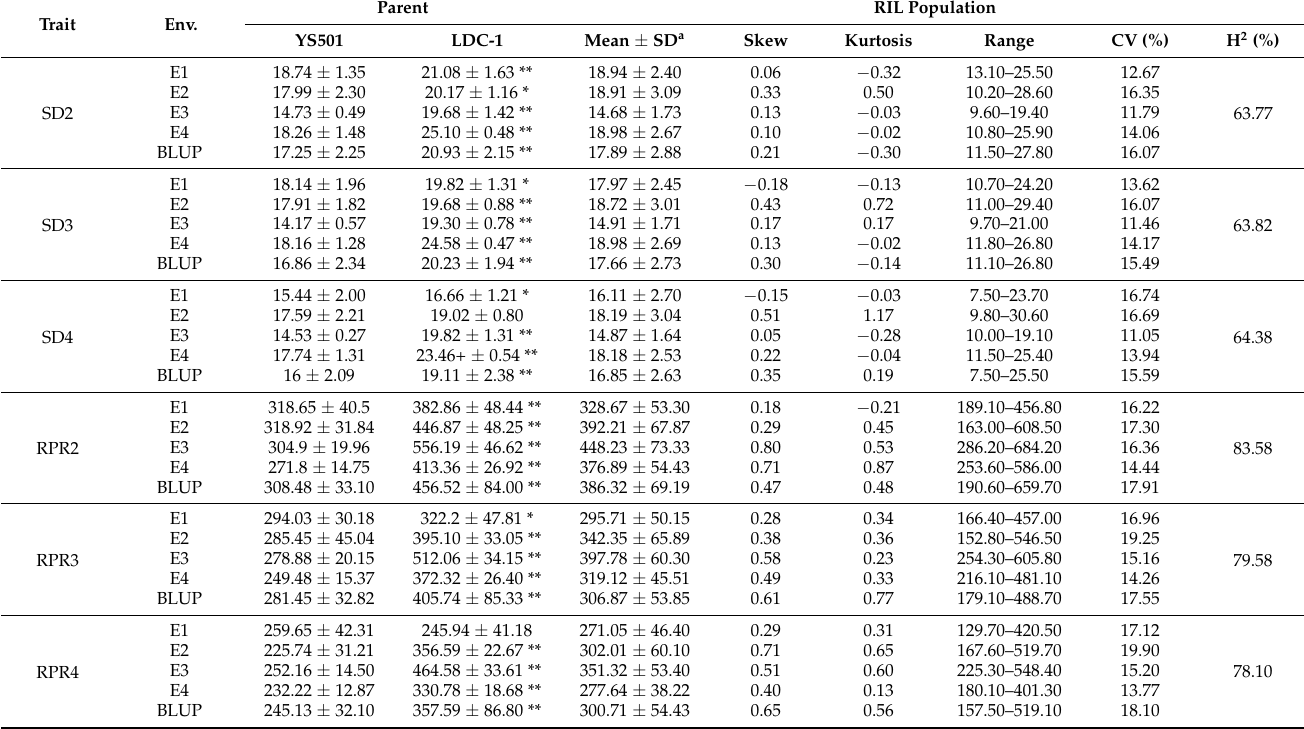
Table 1. Phenotypic variation in the recombinant inbred line (RIL) population and its